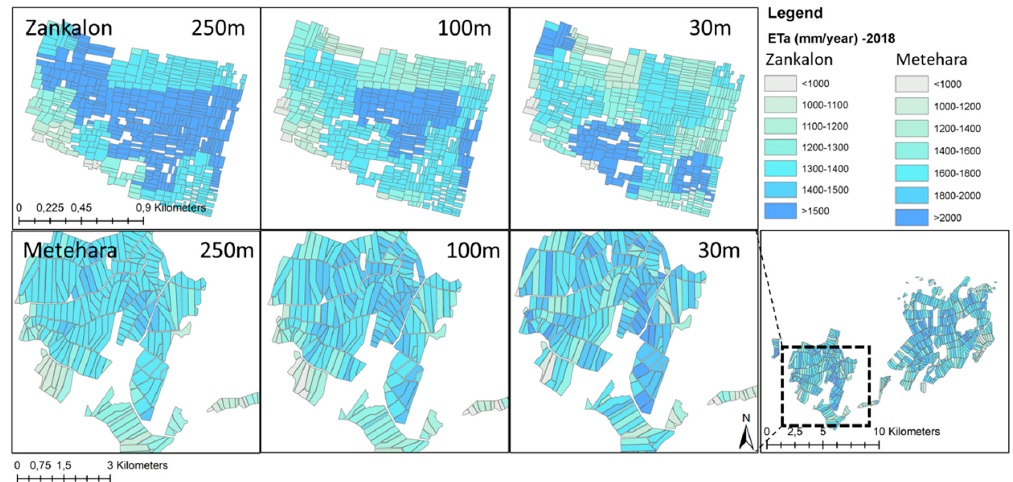
Figure 5. Average plot ETIa in 2018 for the (upper) Zankalon and (lower) Metehara schemes to compare three levels of spatial resolution (L1, L2, L3). three levels of spatial resolution (L1, L2,